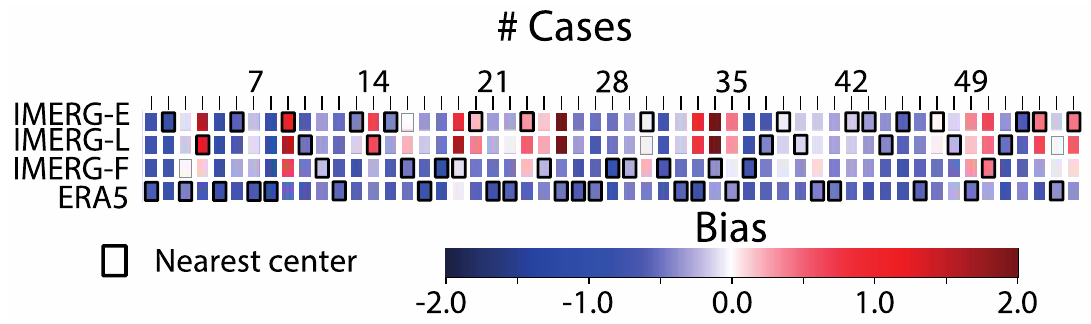
Figure 8. Relative bias of the maximum rainfall pixels for 55 cases. Reds represent positive bias and blues negative bias. Black rectangles indicate the dataset with the nearest maximum rainfall center.